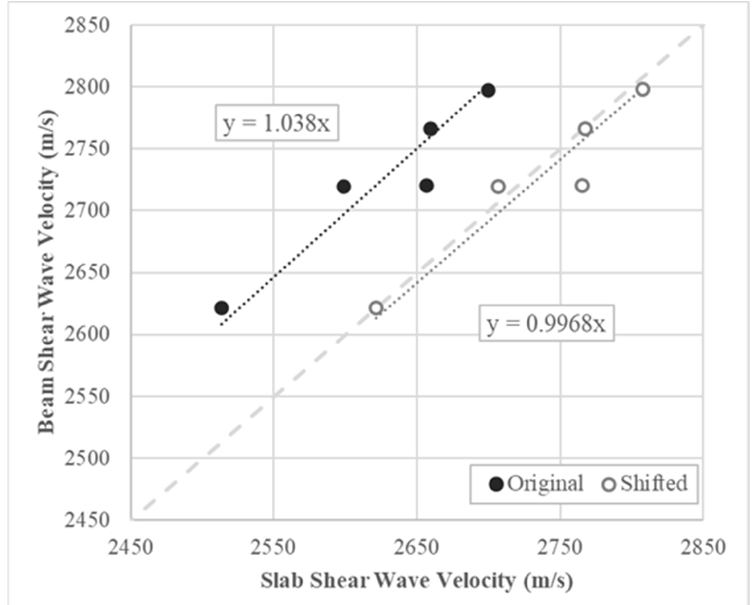
Figure 3. Differences between beam and slab velocities before and after shifting.